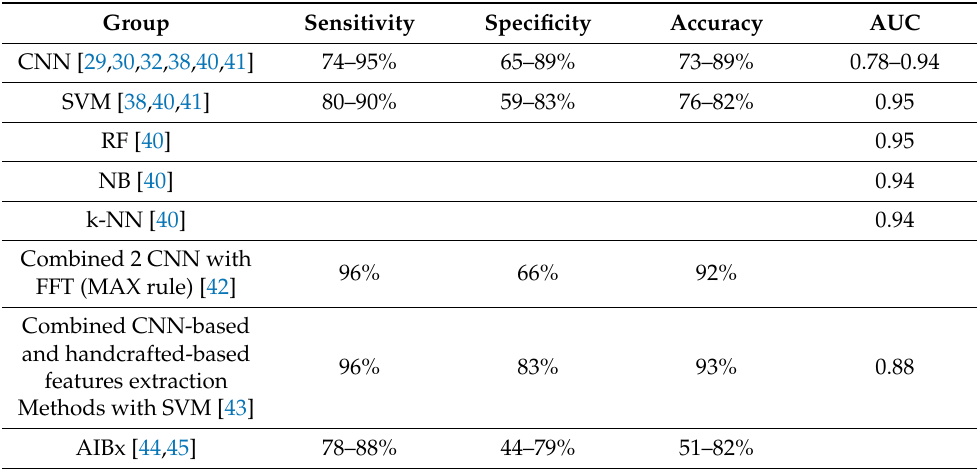
Table 2. Comparison of the performance of different AI